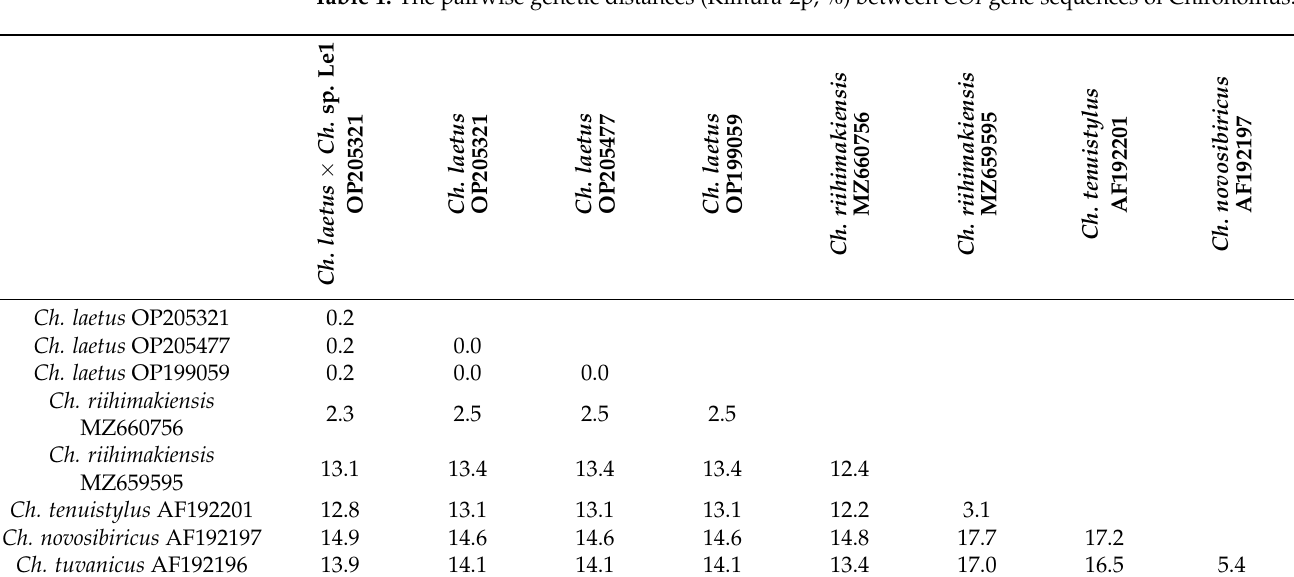
Table 1. The pairwise genetic distances (Kimura-2p, %) between COI gene sequences of Chirono- mus.